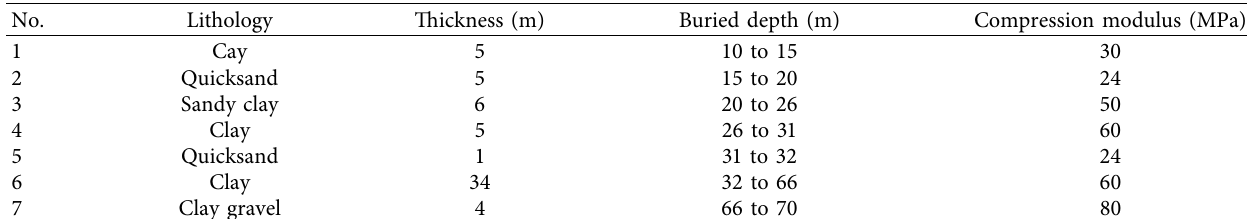
Figure 15: Curves of the additional stress and gravity stress of soil. Table 1: Compressive modulus values of different soil layers below the construction